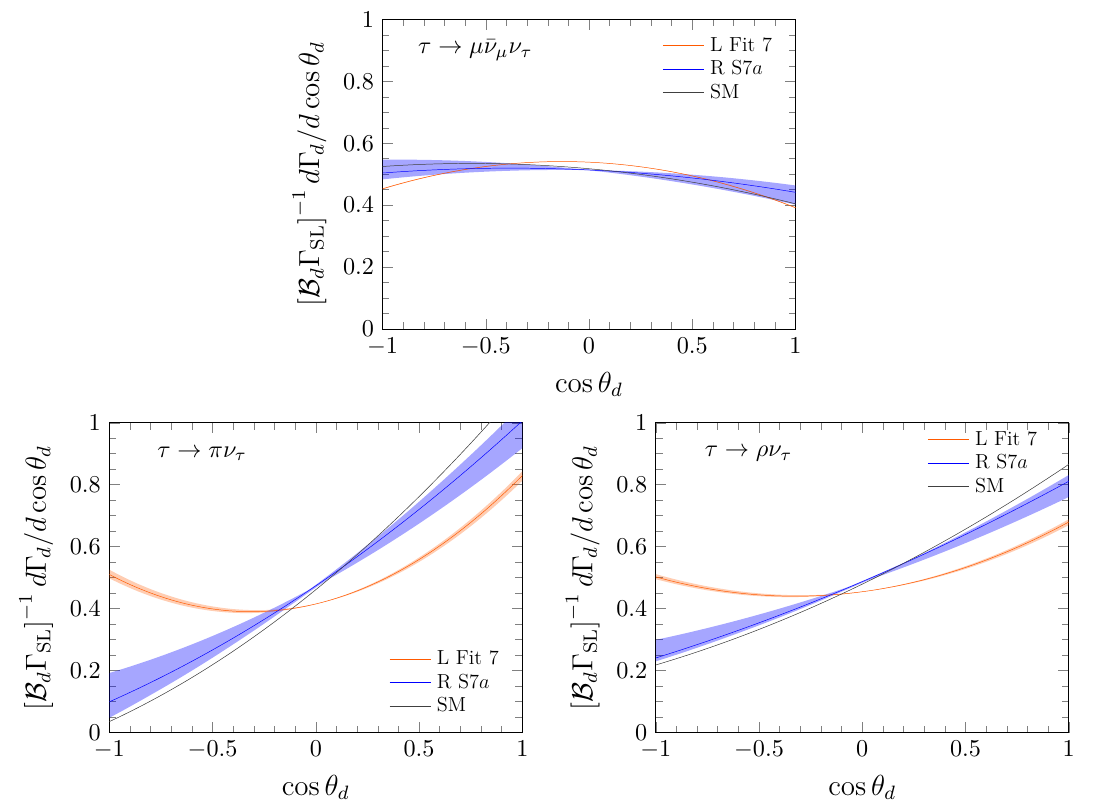
Figure 9 . Angular d Γ /d cos θ d distribution for the ¯ B → Dτ ( µ ¯ ν µ ν τ , πν τ , ρν τ )¯ ν τ decays, keeping y = m d /m τ to its finite value, and obtained within the SM and the beyond the SM scenarios of Fits 7 and 7a of refs. [42] and [45], which only includes left- (right-)handed neutrino NP operators, respectively. Details as in figure